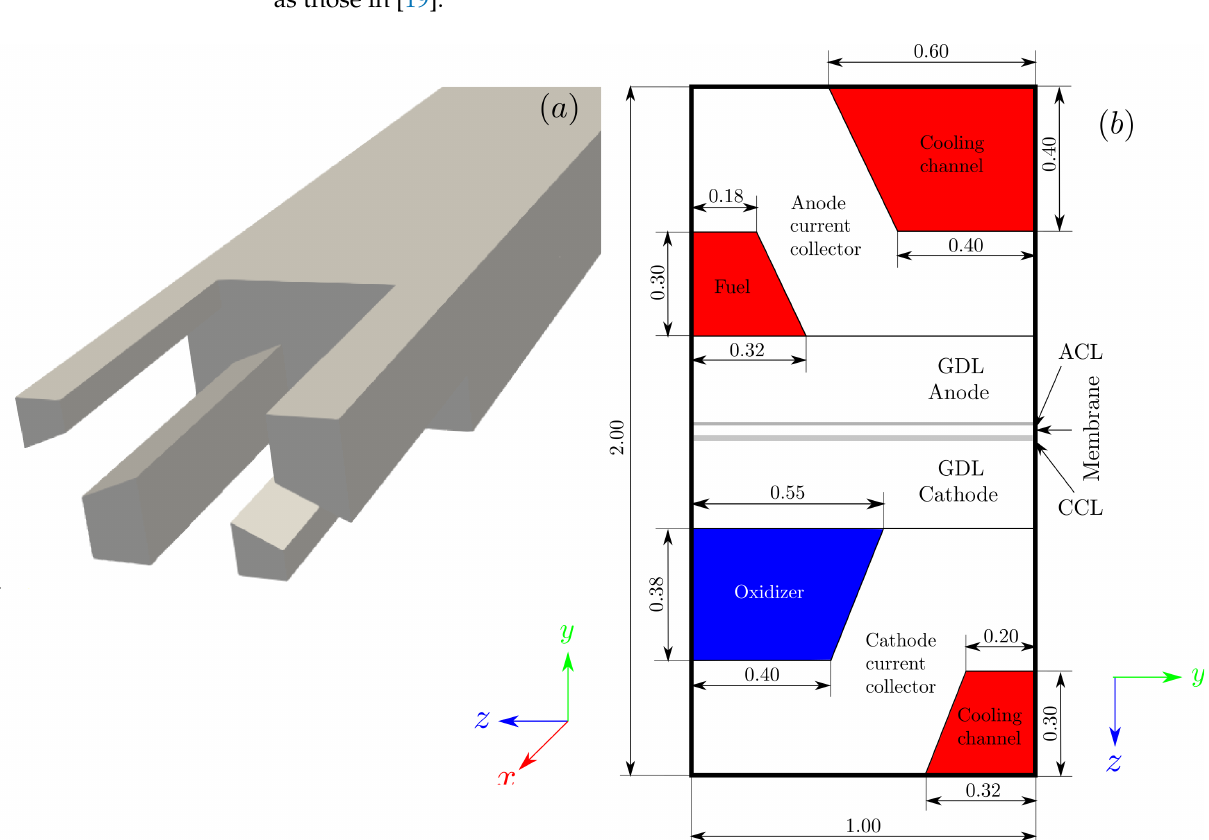
Figure 1. Schematics of the PEMFC domain: ( a ) computational mesh, ( b ) cross-sectional view of the PEMFC